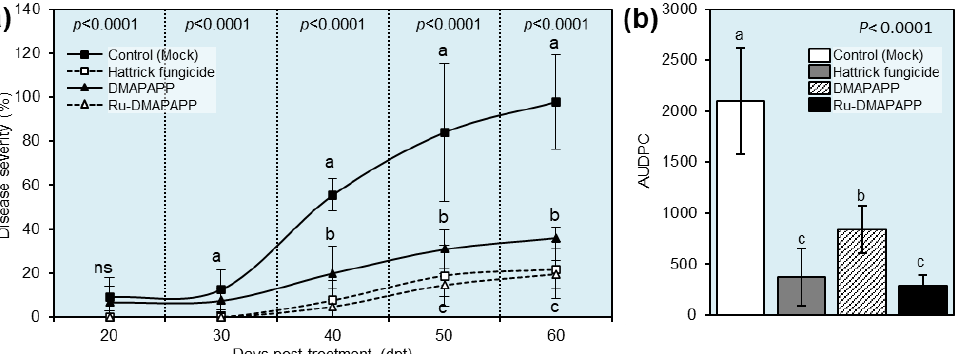
Figure 4. Effect of two bis-chalcone derivatives, DMAPAPP and Ru-DMAPAPP, on the development of pepper Fusarium wilt disease caused by Fusarium equiseti under greenhouse conditions. ( a ) Disease progress curves of fusarium wilt disease on pepper plants after treatment with DMAPAPP and Ru-DMAPAPP. ( b ) The area under the disease progress curve (AUDPC) of fusarium wilt disease on pepper plants after the treatment with DMAPAPP and Ru-DMAPAPP. Values represent the means ± standard deviations. Different letters indicate statistically significant differences between treatments using the Tukey – Kramer honestly significant difference test (Tukey HSD; p < 0.05).